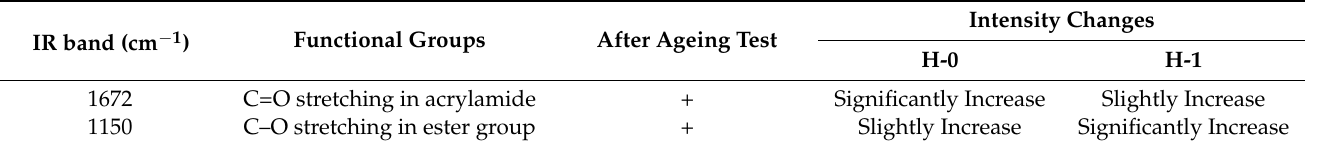
Figure 13. FTIR spectra of the H-0 sample ( a ) and the H-1 sample ( b ) after different ageing times. Table 4. FTIR assignments for the functional groups of H-0 and H-1 sample after ageing test.